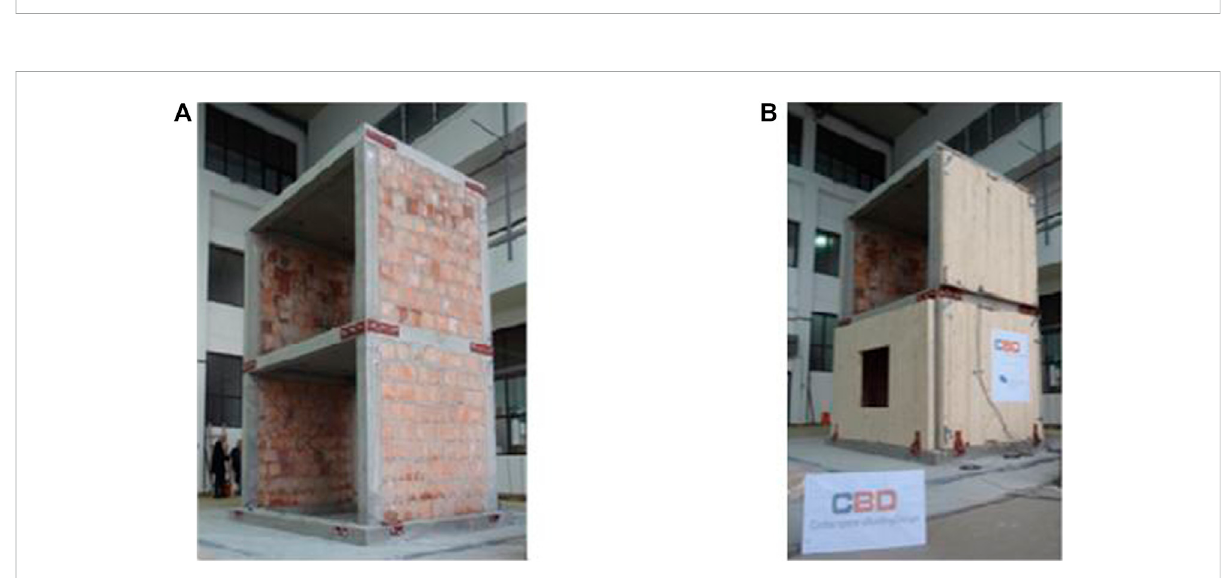
FIGURE 7 RC frame with masonry in fi ll walls: (A) not retro fi tted and (B) retro fi tted structures with CLT panels (adapted from (Sustersic and Dujic, 2014))